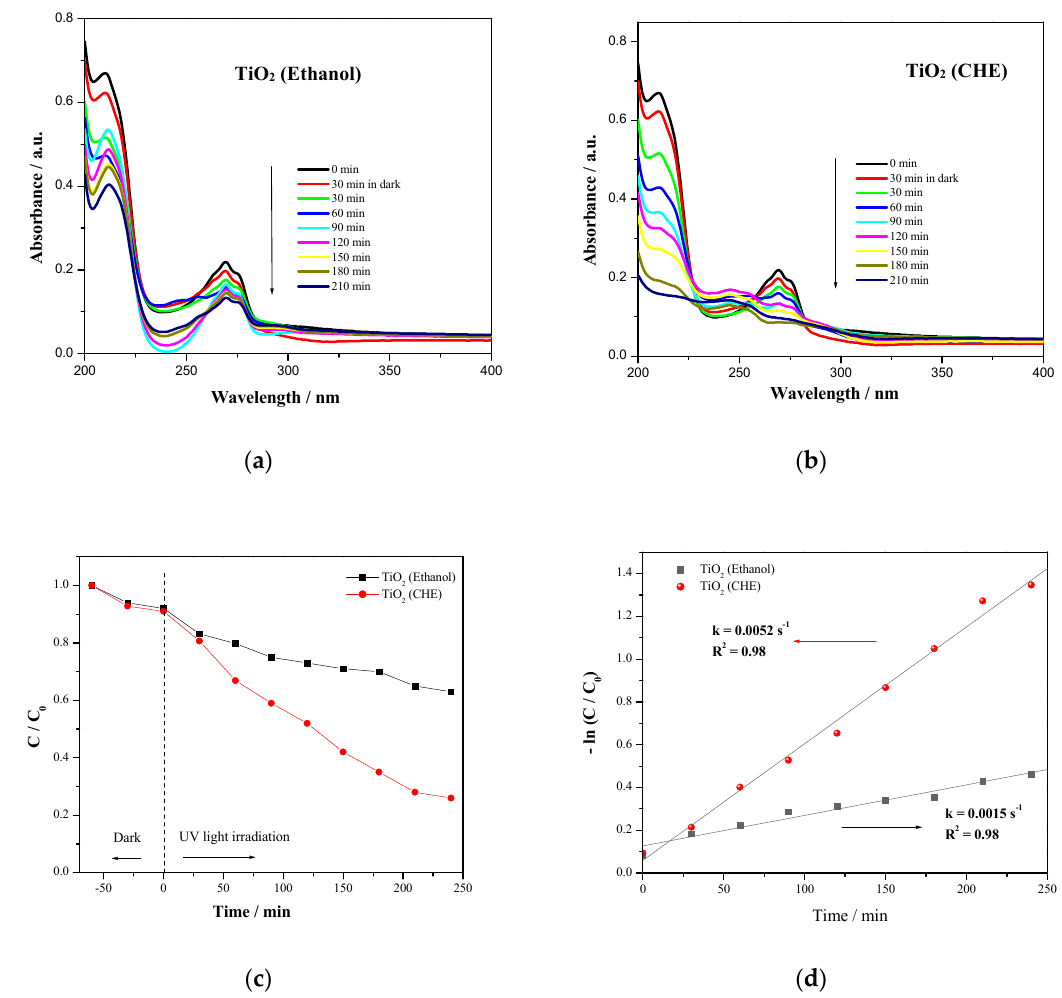
Figure 8. ( a , b ) UV-vis absorption spectra of an aqueous solution of phenol during solar light illumination in the presence of the as synthesized TiO 2 (Ethanol) and TiO 2 (CHE), respectively; ( c ) efficiency of the photocatalytic degradation of MB as the variation of C/C 0 with irradiation time in the presence of various nanomaterials; ( d ) linear plots of –ln C/C 0 vs. time for the experimental data in Figure 8c.